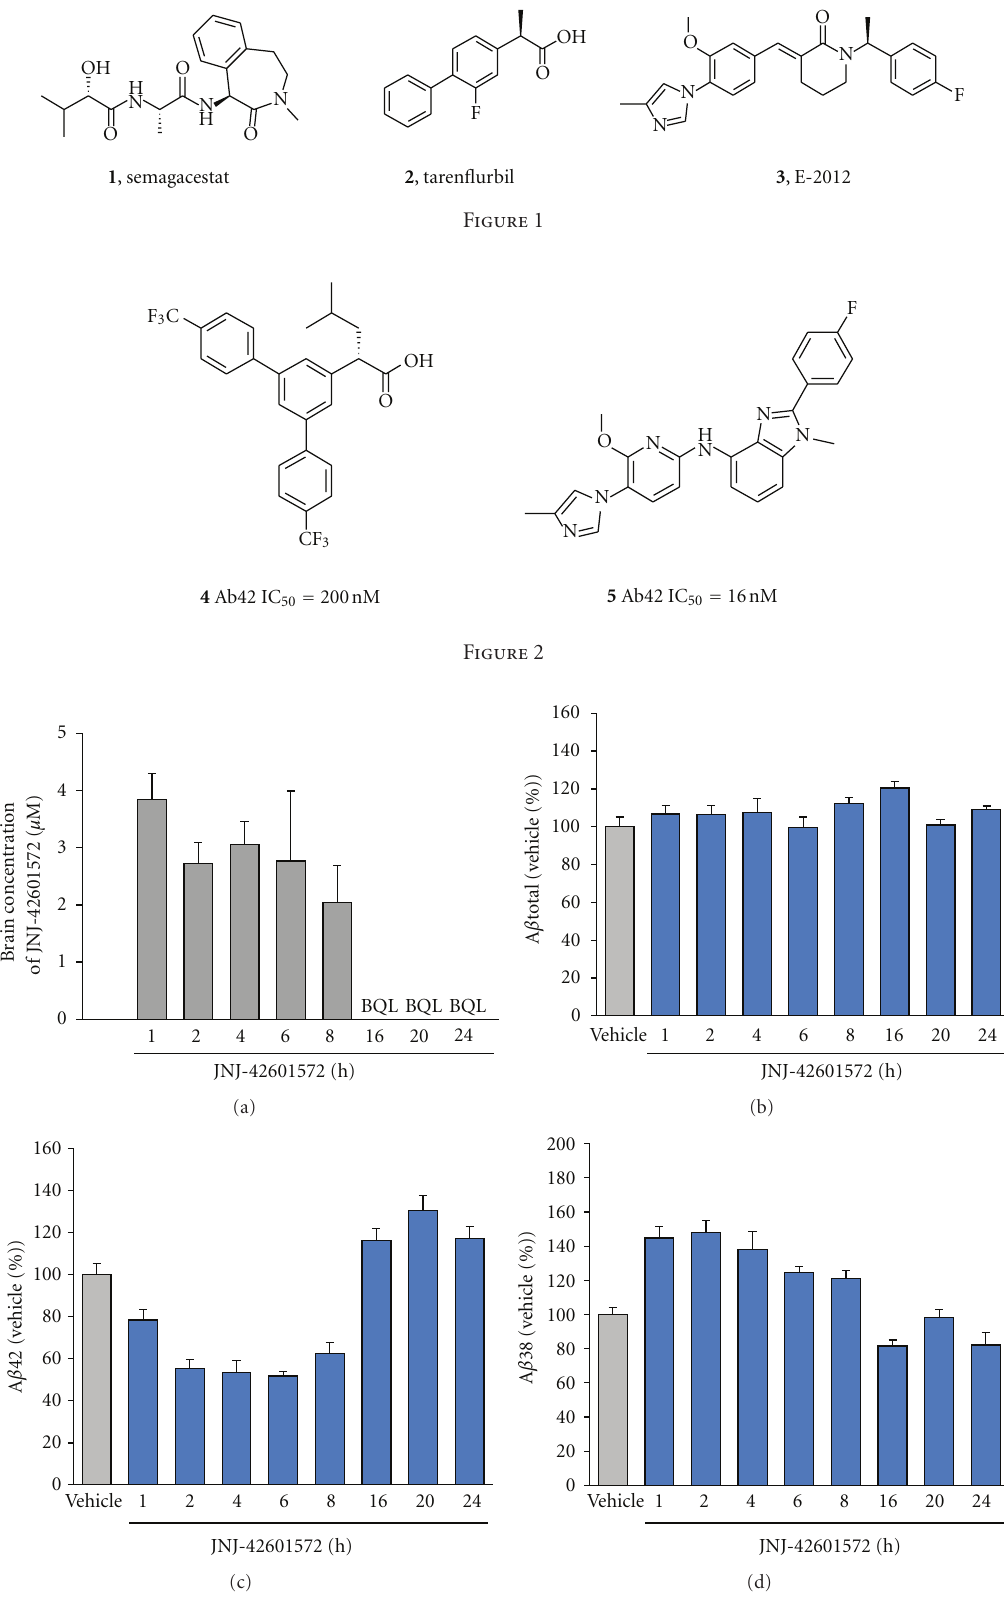
Figure 3: E ff ects of a single oral dose of 10 mg/kg JNJ-42601572 on A β levels in nontransgenic mouse brain as measured with di ff erential ELISAs [16]. Mean (+SEM) brain A β levels after drug treatment are expressed as percentage of A β levels in brain of vehicle-treated mice. ( n = 6 mice per data point). BQL: below quantifiable limits (in brain 0.07–0.12 μ